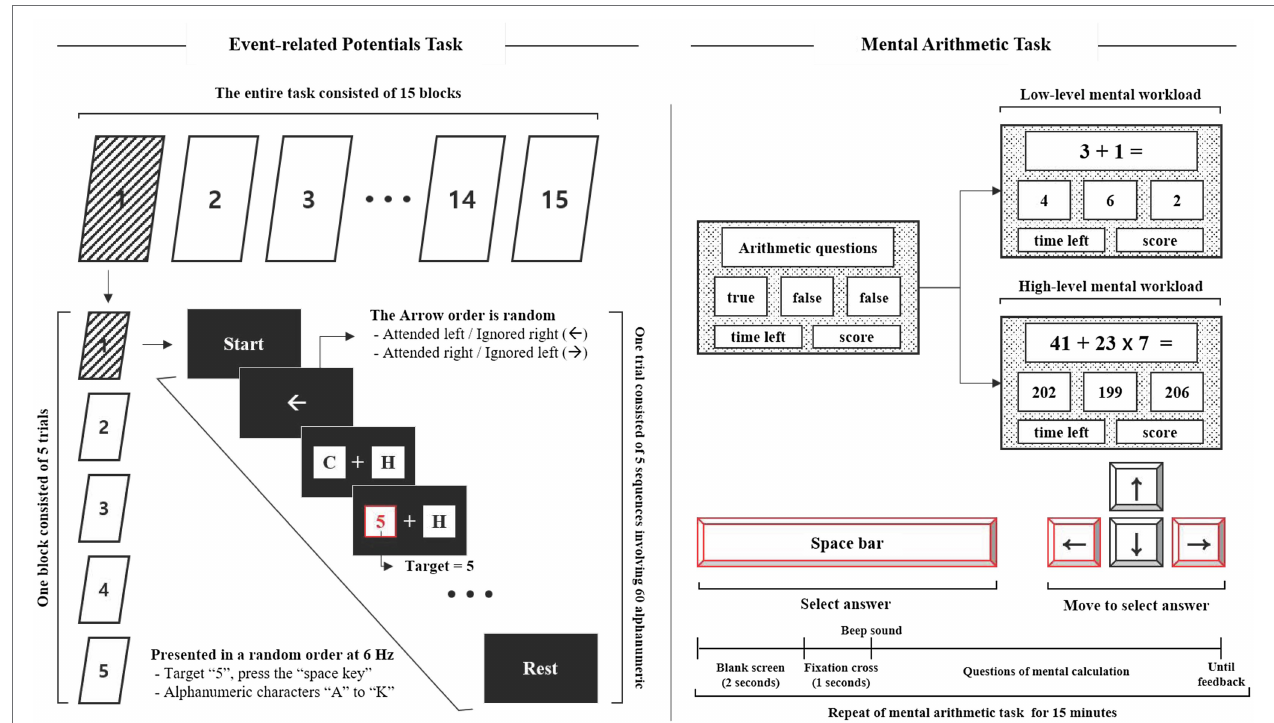
FIGURE 1 | Experimental stimuli to measure ERP responses (left) and cause mental workload